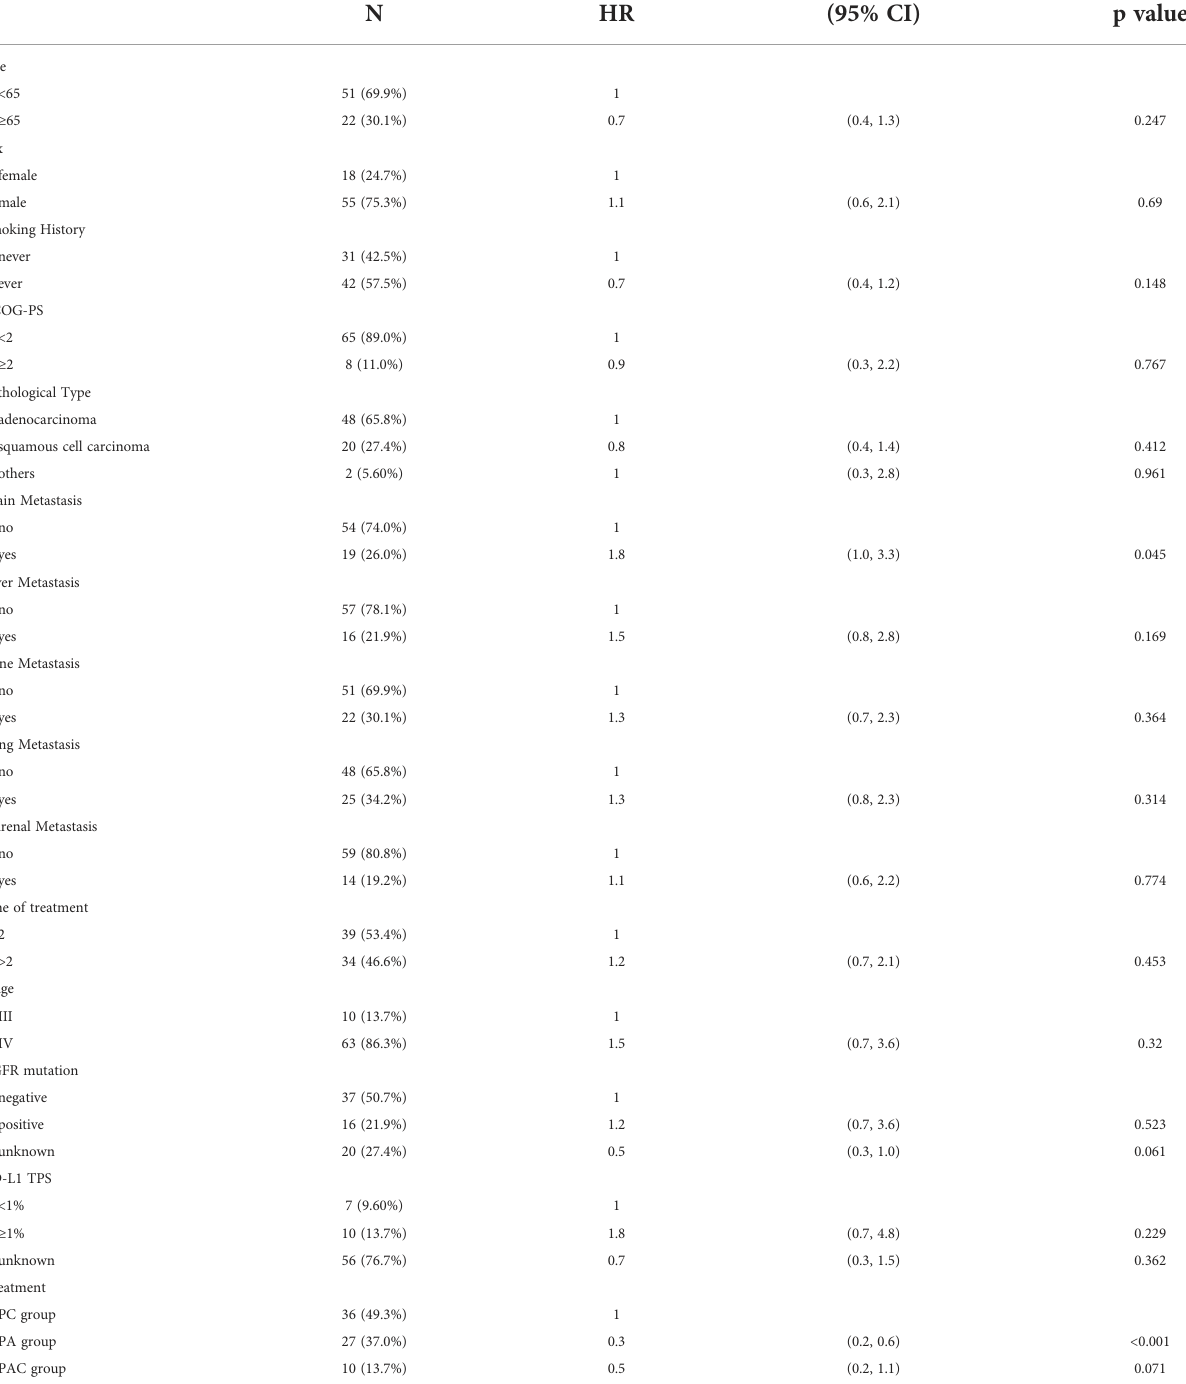
TABLE 2 Univariate cox regression analysis of clinical indicators to predict risk of disease progression. N HR (95%